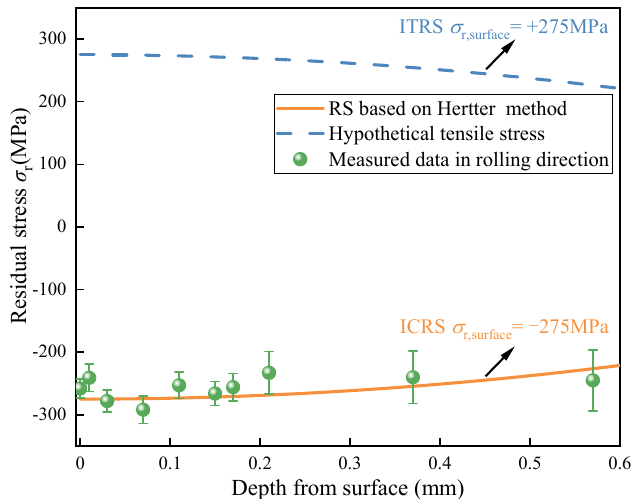
Figure 10. The measured residual stress data and the empirical stress curve.